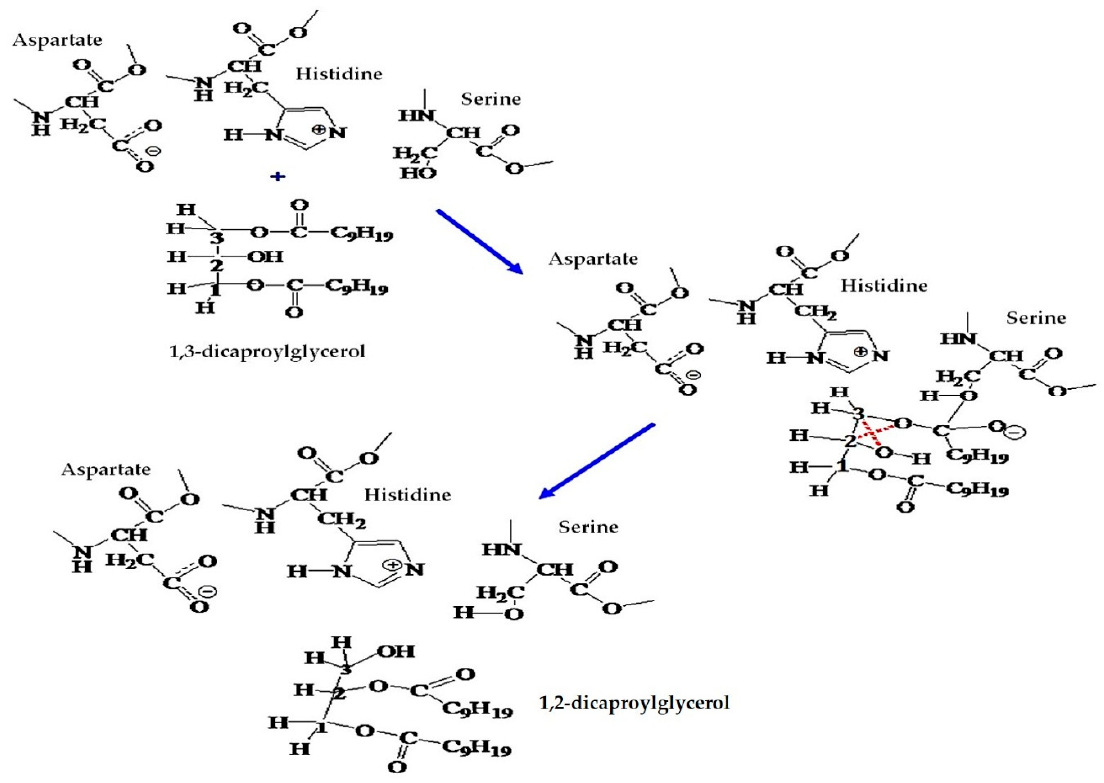
Figure 3. Diagram of acyl migration in 1,3 DAG with the OH of C2 positioned towards the Serine side.